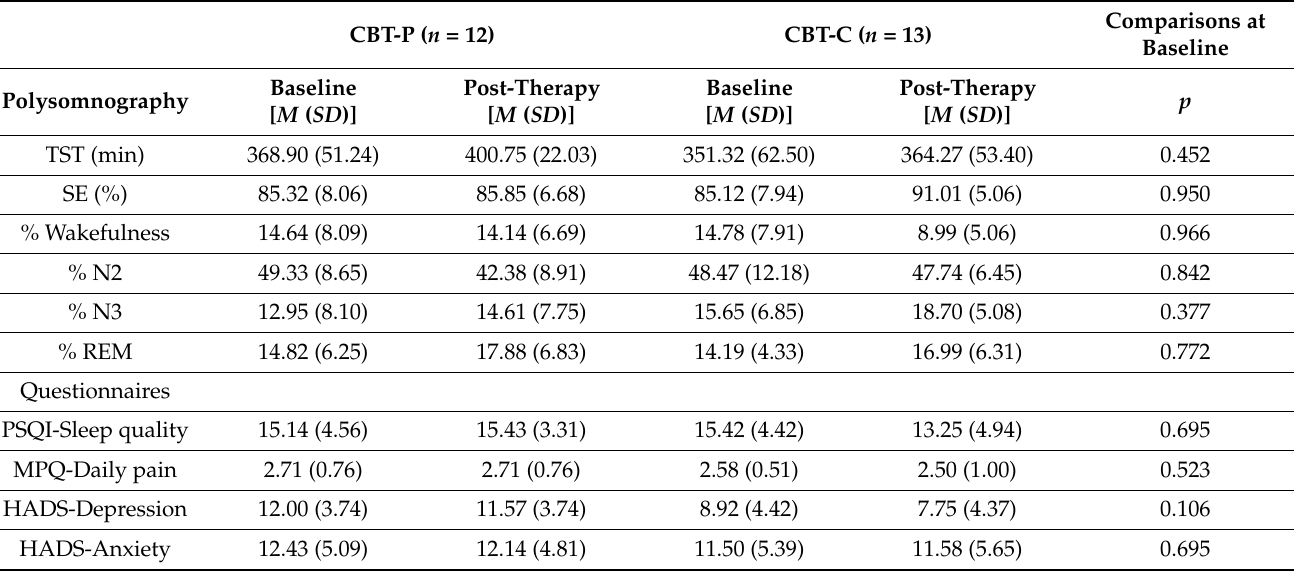
Table 3. Polysomnographic and psychometric